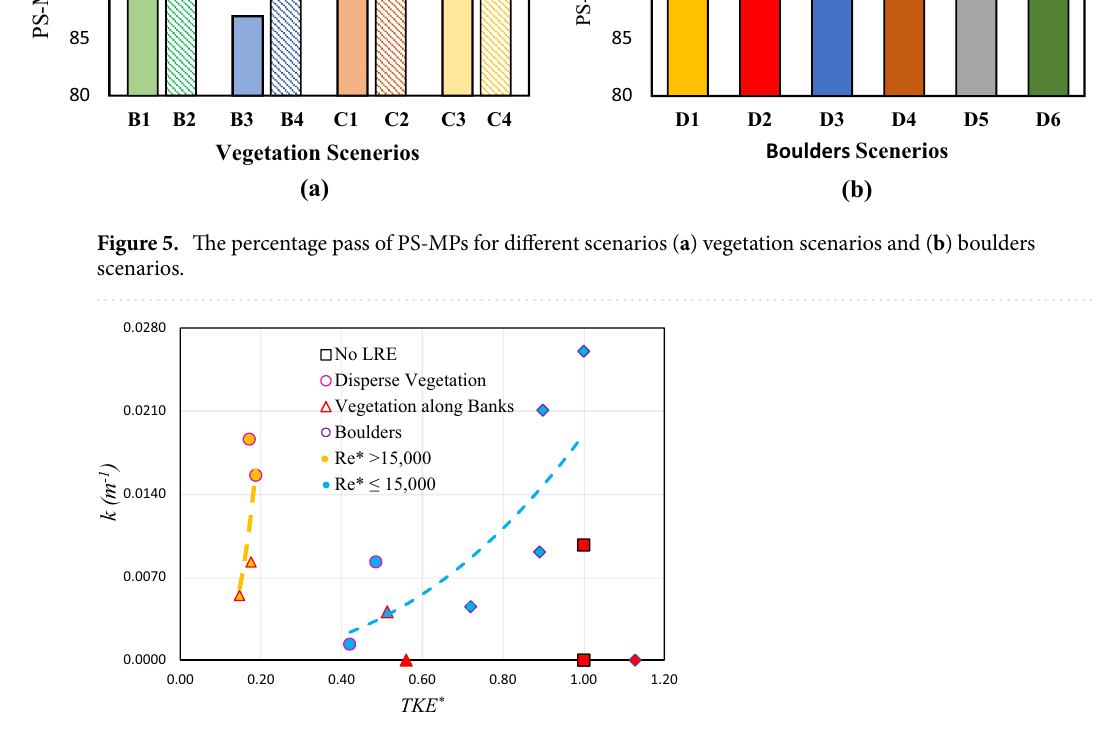
Figure 6. The relationship between dimensionless turbulence kinetic energy ( TKE ∗ ) and retention coefficient (k) for low and high shear Reynolds number ( R ∗ e ) series of experiment. (The red data points are considered outliers and not considered in the nonlinear regression